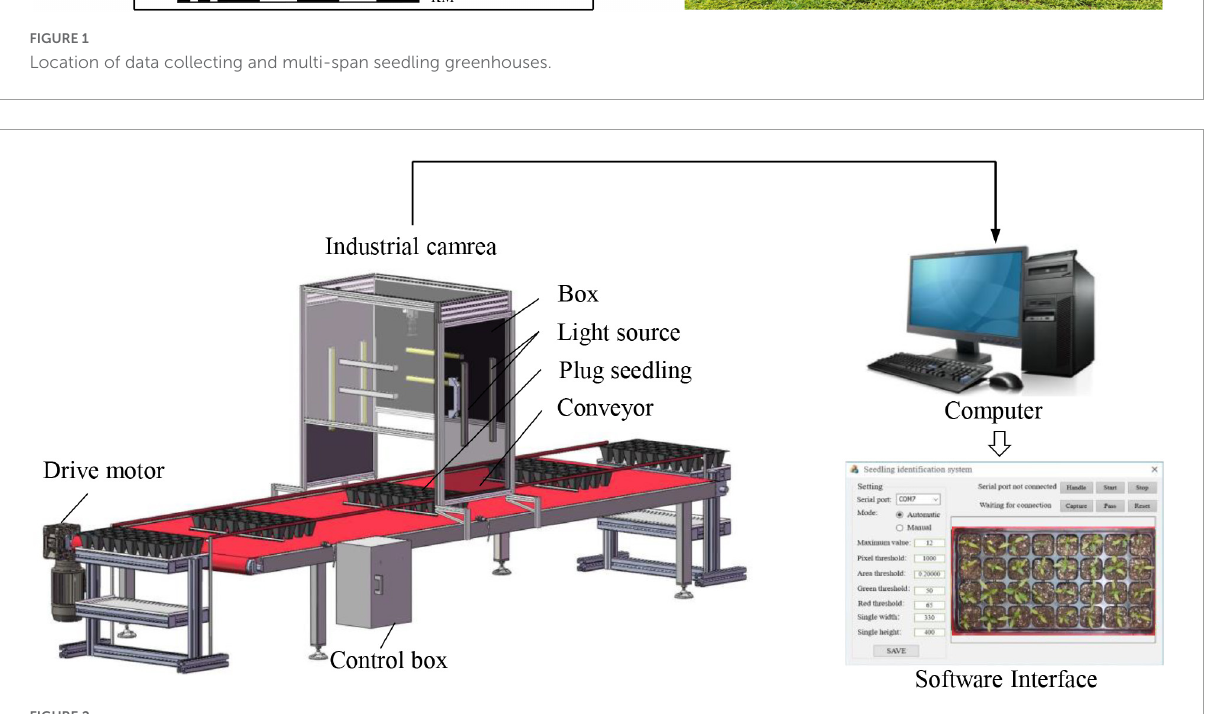
FIGURE2 Picture capture